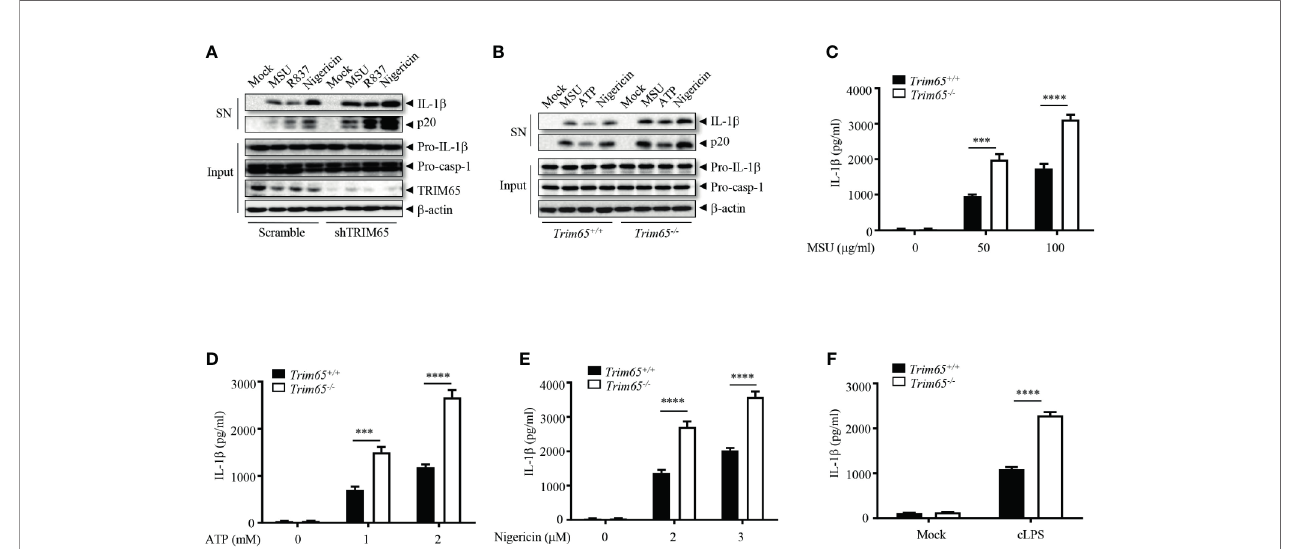
FIGURE 2 | TRIM65 inhibits NLRP3 in fl ammasome activation in macrophage. (A) PMA-differentiated and LPS-primed THP-1 cells stably expressing shRNA targeting TRIM65 mRNA were stimulated with MSU, R837 or nigericin. Cleaved IL-1 b , activated caspase-1 (P20) in the SN and pro-IL-1 b and pro-caspase-1 in the input were analyzed by western blotting. (B-F) LPS-primed BMDMs from wild-type and Trim65 -/- mice were stimulated with MSU, ATP, nigericin (B – E) , or cytosolic LPS (F) . Cleaved IL-1 b , activated caspase-1 (P20) in the culture supernatants and pro-IL-1 b and pro-caspase-1 in cell lysates were analyzed by western blotting (B) . Cleaved IL-1 b in the culture supernatants was assayed by ELISA (C – F) . Data are representative of three independent experiments of duplicate biological repeats (A, B) . SN, media supernatants; Input, cell extracts. Student ’ s t -test, *** P < 0.001, **** P < 0.0001. Data are shown as the means ± SEM of three independent experiments (C – F)